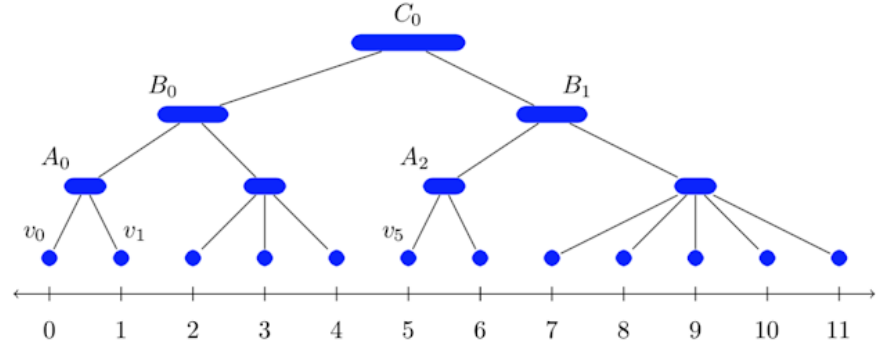
Figure 2. Illustration of Affinity tree ordering. The nodes at the bottom row correspond to the vertices of the graph and the nodes at the higher levels are formed by merging nodes from lower levels. The vertices are finally sorted in the picture according to their labels. For instance, the label for v 0